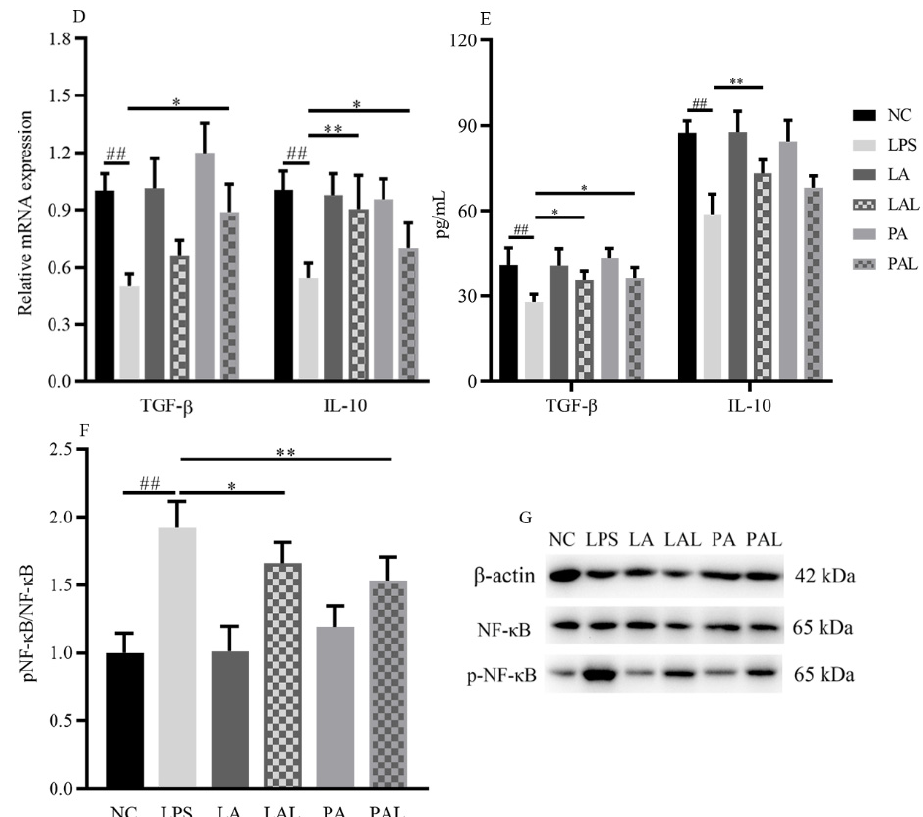
Figure 1. A. muciniphila inhibits LPS-induced inflammatory responses. ( A ) The experiment design of Caco-2 cells pretreatment with A. muciniphila . ( B , C ) The effect of A. muciniphila on expressions of TNF- α , IL-1 α , IL-1 β , IL-6, IL-8, ( D , E ) TGF- β , and IL-10 in Caco-2 cells. ( F , G ) A. muciniphila inhibits the activation of the NF- κ B signaling pathway. ** p < 0.01, * p < 0.05, compared with LPS, ## p < 0.01, # p < 0.05, compared with NC group, && p < 0.01, LAL compared with PAL. Data are expressed as mean ± S.D. ( n = 6). LPS, lipopolysaccharide. NF- κ B, Nuclear Factor-Kappa